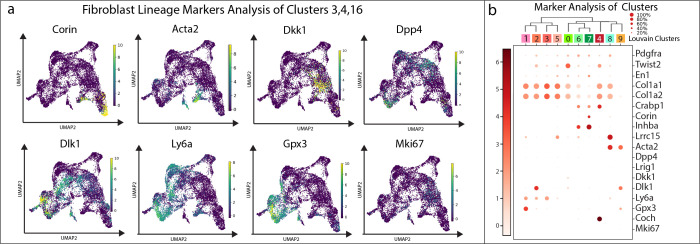
Classifying fibroblast clusters and conditions in development, regeneration, scarring, and homeostasis.(a) Over-laying gene expression for cell markers on UMAP plots. (b) Dotplot of genes based on expression in cluster.